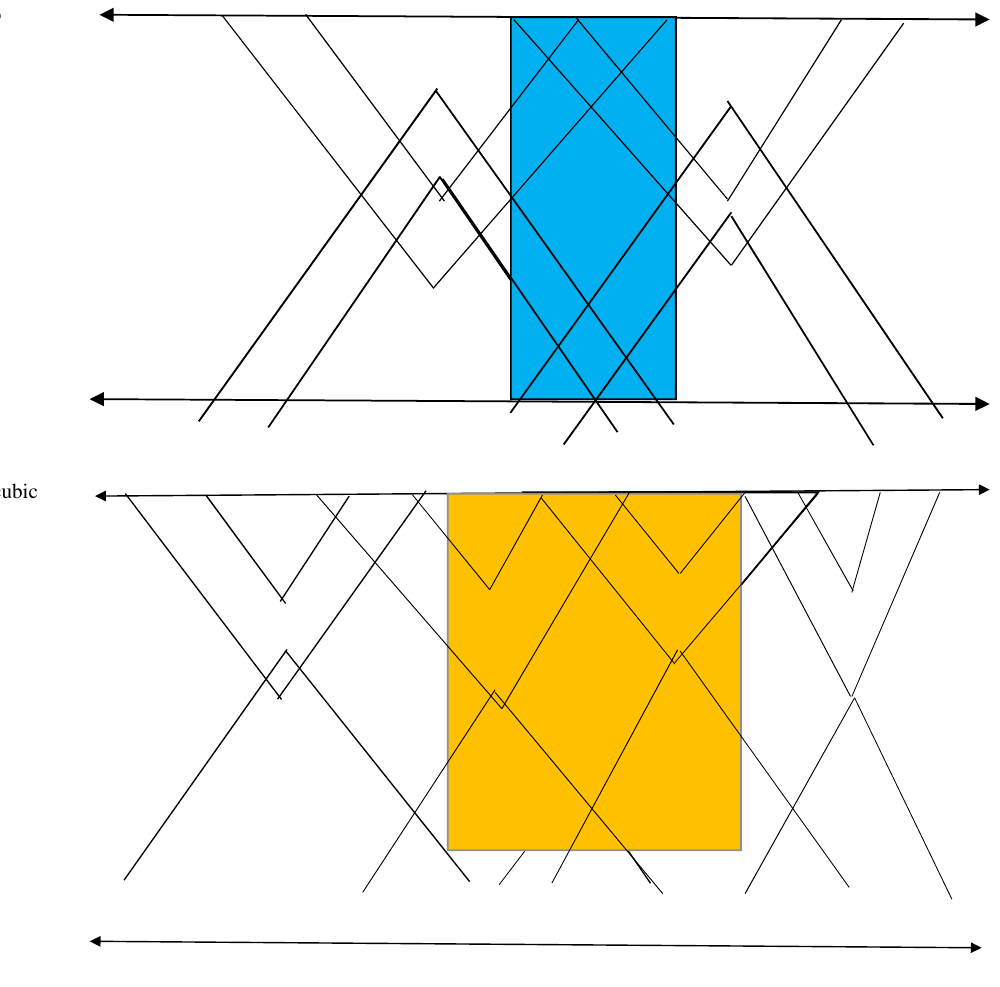
Fig. 3 Similar portion of N-cubic Pythagorean fuzzy